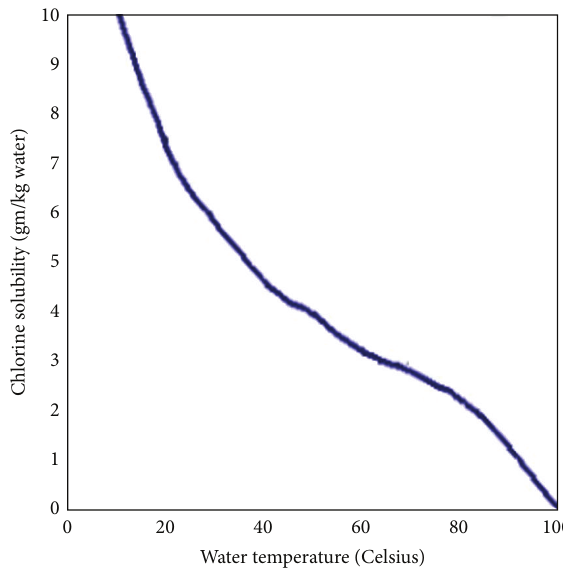
Figure 3: Chlorine solubility in water.